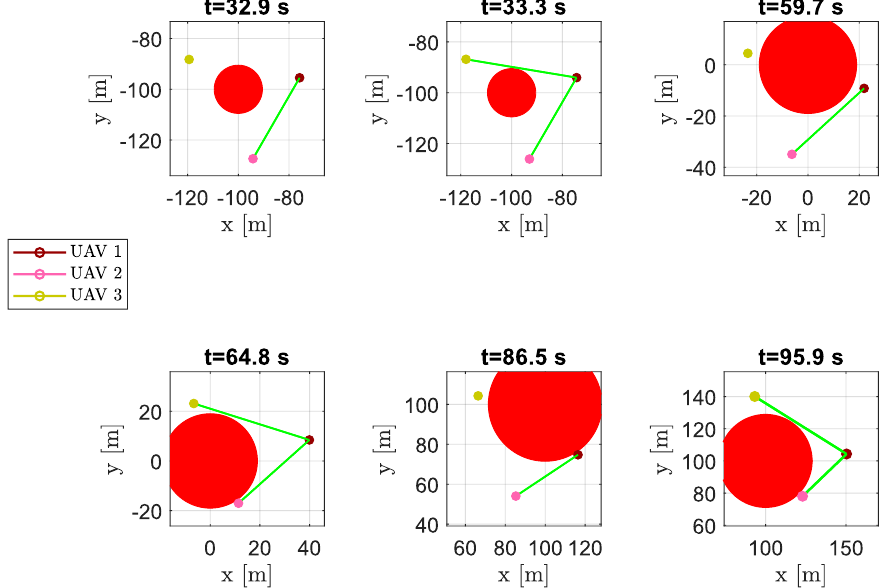
Figure 8. Scenario #1—three aircraft: snapshots of UAVs’ positions at different time instants. Colored markers indicate UAVs’ actual positions; straight green lines show the DTG arcs. Several swarm configurations during obstacle avoidance are highlighted.